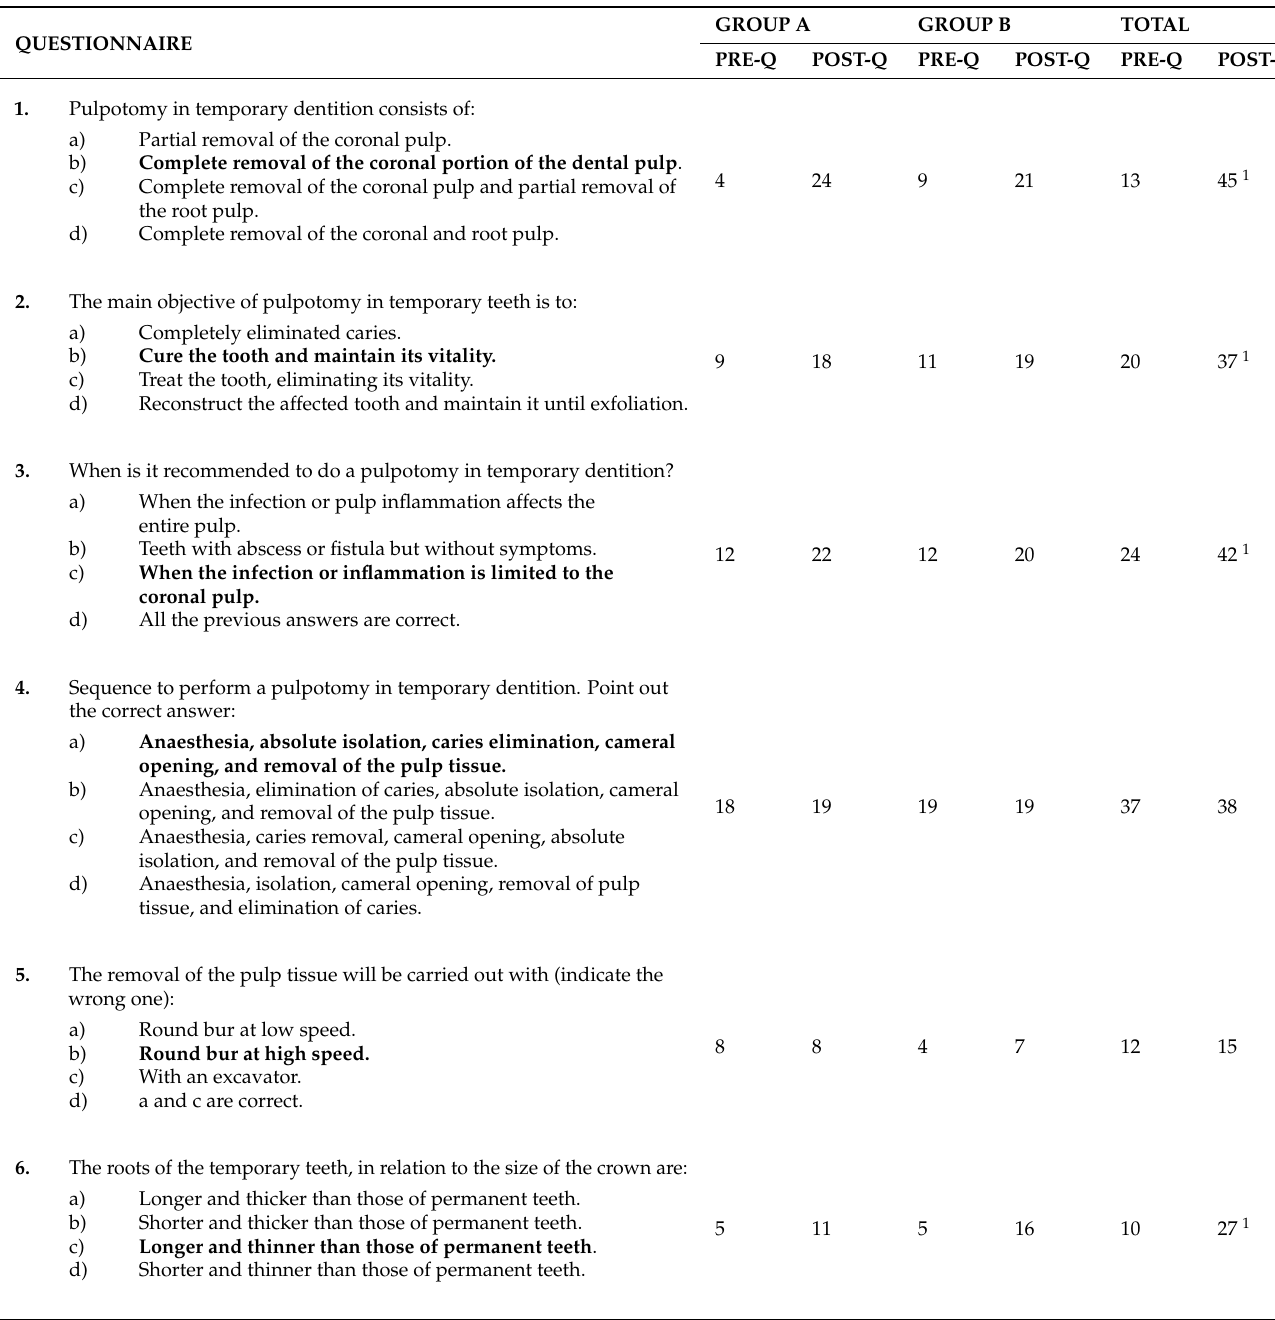
Table 1. Correct answers to the pulpotomy knowledge questionnaire. The correct answer is shown in bold. Significant differences between Pre-Q and Post-Q (learning of each question: McNemar’s